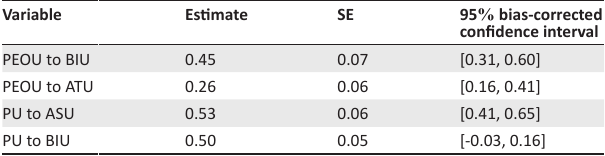
FIGURE 3: Structural model of technology TABLE 7: Indirect effects of perceived ease of use and perceived usefulness.